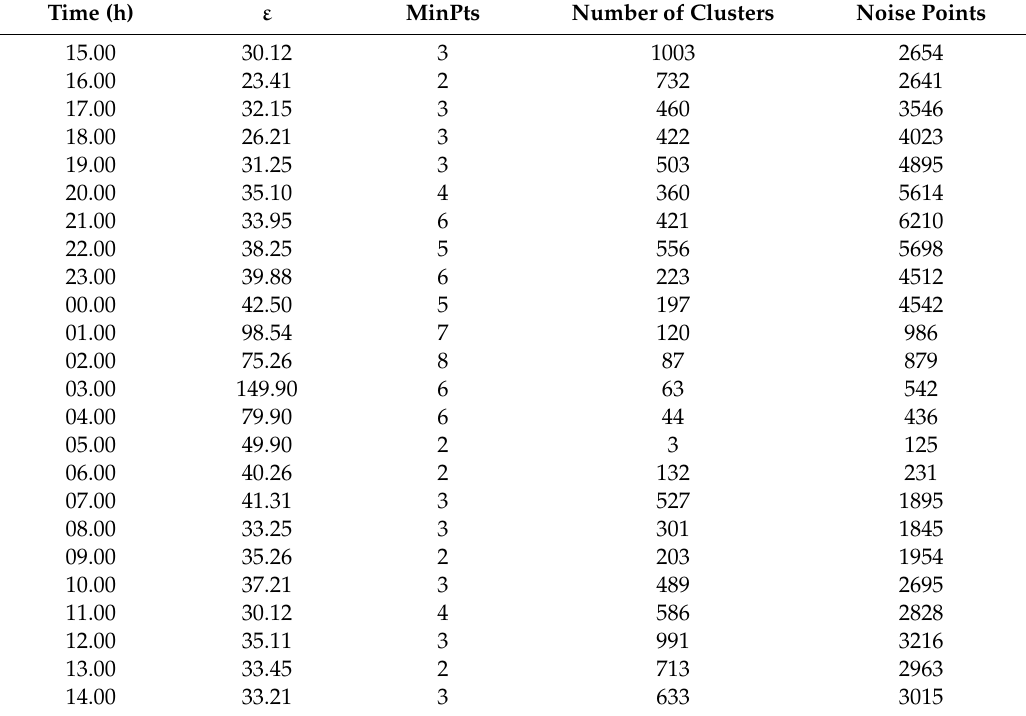
Table 2. SOM and DBSCAN, first stage clustering results in a normal day in